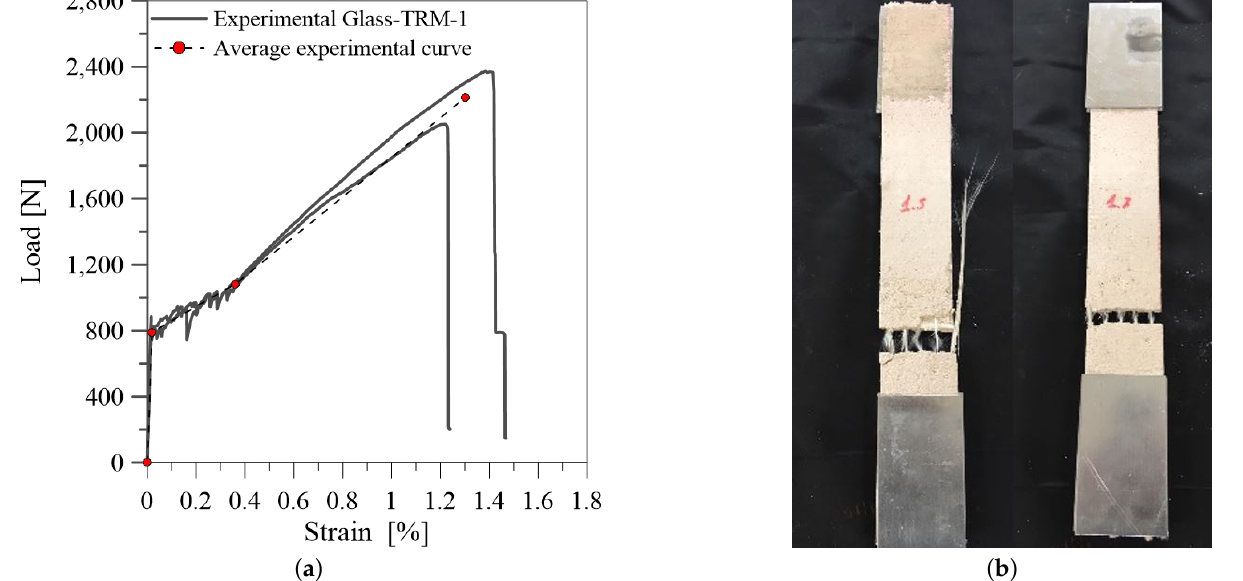
Figure 4. Tensile test on specimens TRM-1: ( a ) tensile load-axial strain curve; ( b ) failure